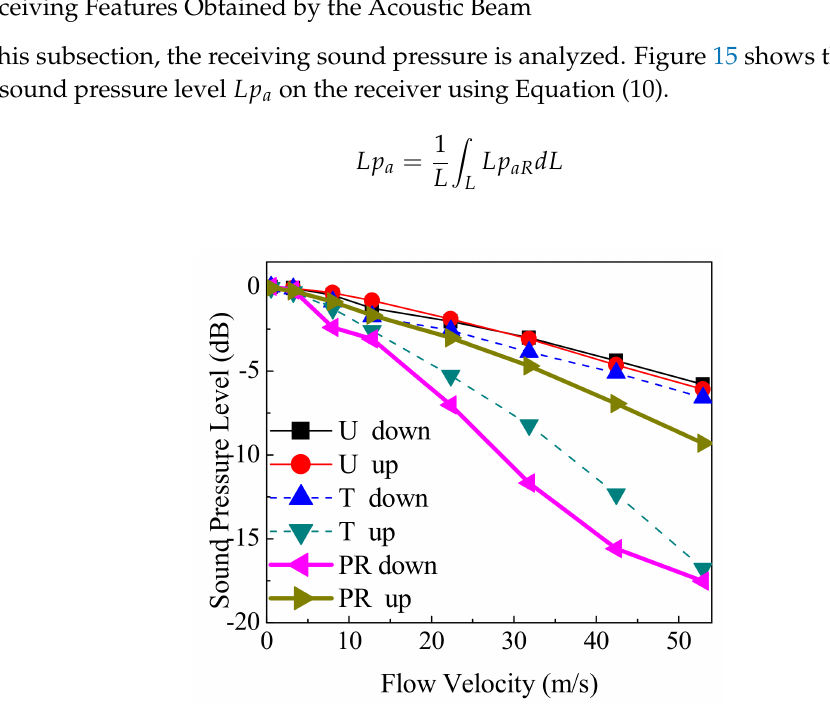
Figure 15. Sound pressure on the receiver for different flow